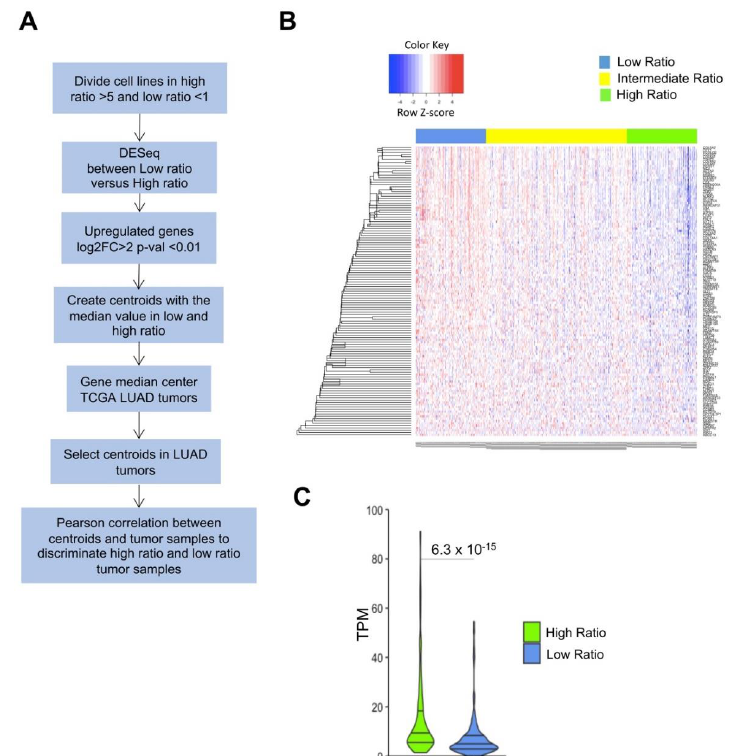
Figure 6. Identification and validation of a gene signature in NF-YAs / NF-YAl low ratio cell lines. ( A ) Overall scheme of the analysis. ( B ) Heatmap of expression levels of 125 genes identified as upregulated in low ratio cell lines. Color key indicates the Z -score. ( C ) Boxplots of NF-YAs / NF-YAl ratio distribution across TCGA LUAD samples after partitioning based on cell line signature. Analysis of the 130 centroid genes in LUAD tumors with high and low NF-YAs / NF-YAl ratios. p -values were calculated using a Wilcoxon signed-rank Z -test with Bonferroni